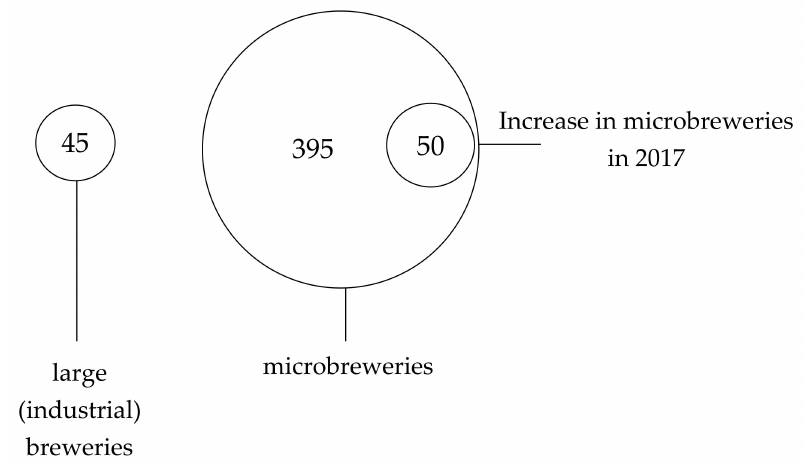
Figure 4. Numbers of breweries in Czechia in 2017